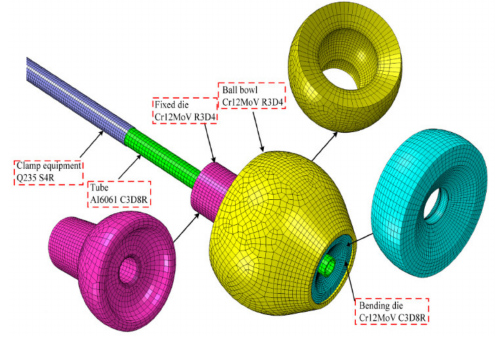
Figure 6. FEM of a 3D spatial free bending